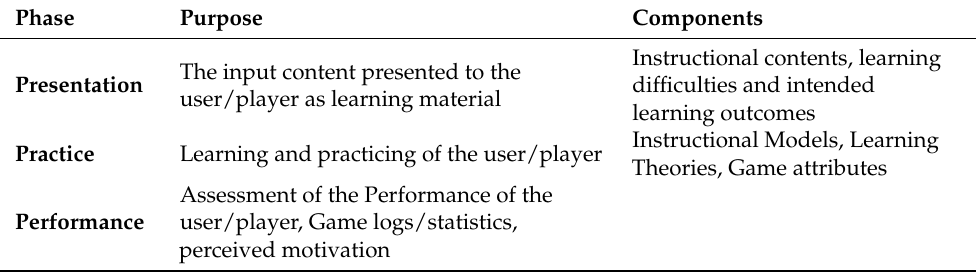
Table 1. Placement of the components in the SG model’s